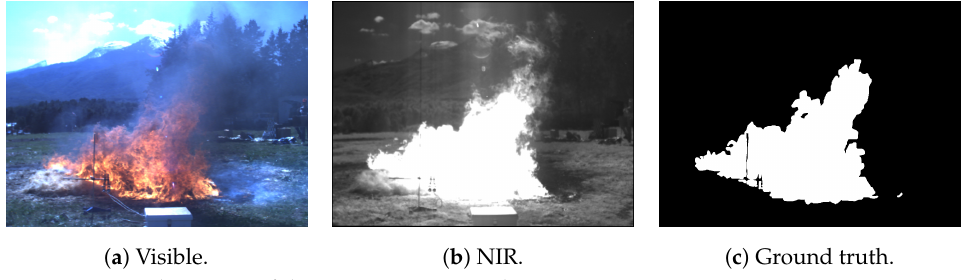
Figure 3. Sample images of the Corsican Fire